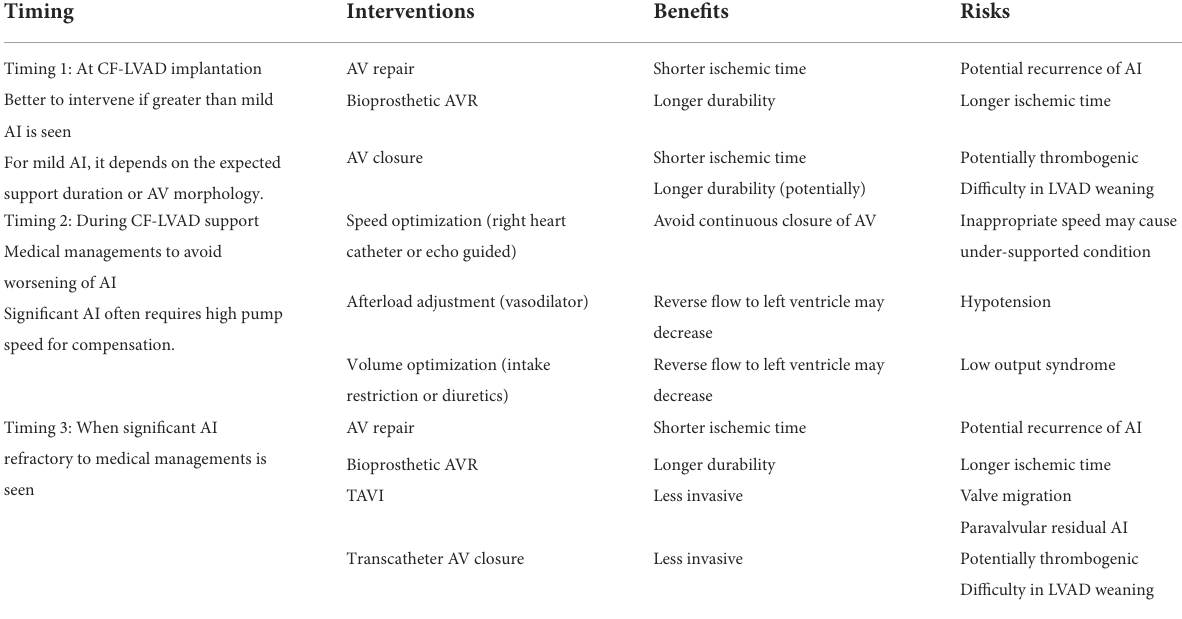
TABLE 2 Summary of suggested medical and surgical interventions to treat aortic insufficiency in patients support by continuous-flow LVAD.